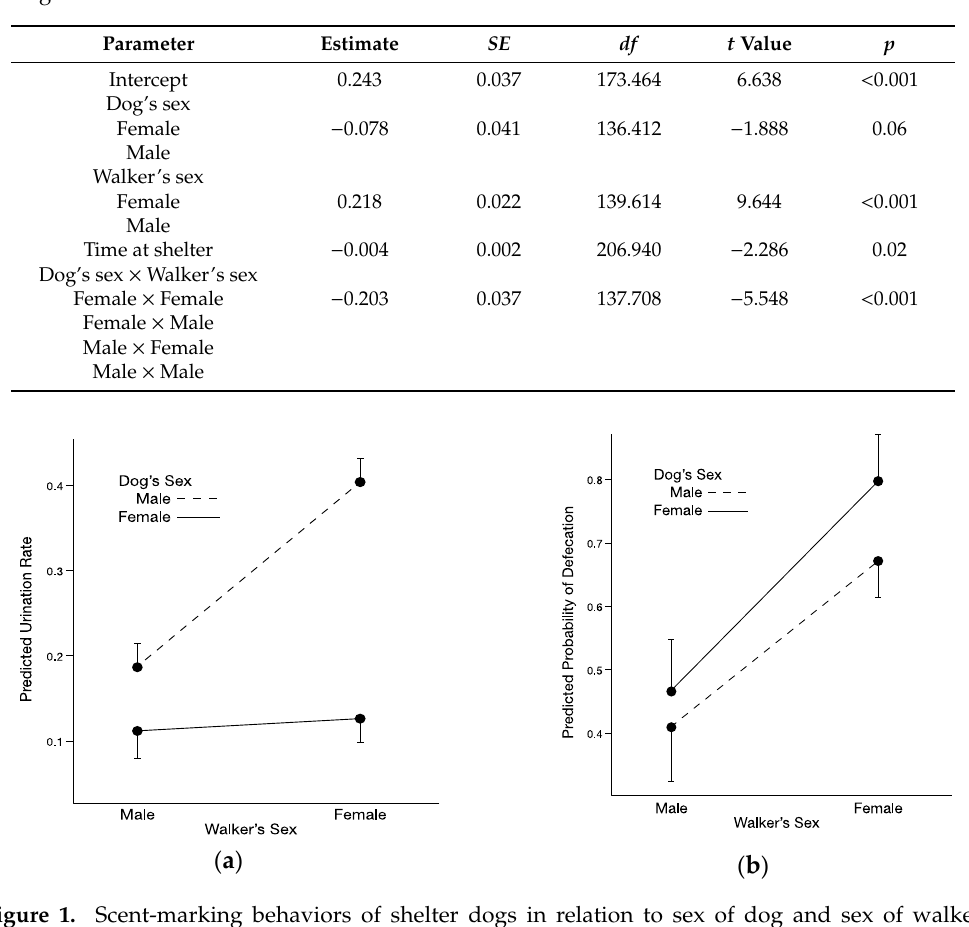
Figure 1. Scent-marking behaviors of shelter dogs in relation to sex of dog and sex of walker. ( a ) Predicted rates of urination by male and female dogs when walked by male or female walkers. ( b ) Predicted probabilities of defecation by male and female dogs when walked by male or female walkers. Walks were 20 min in duration.